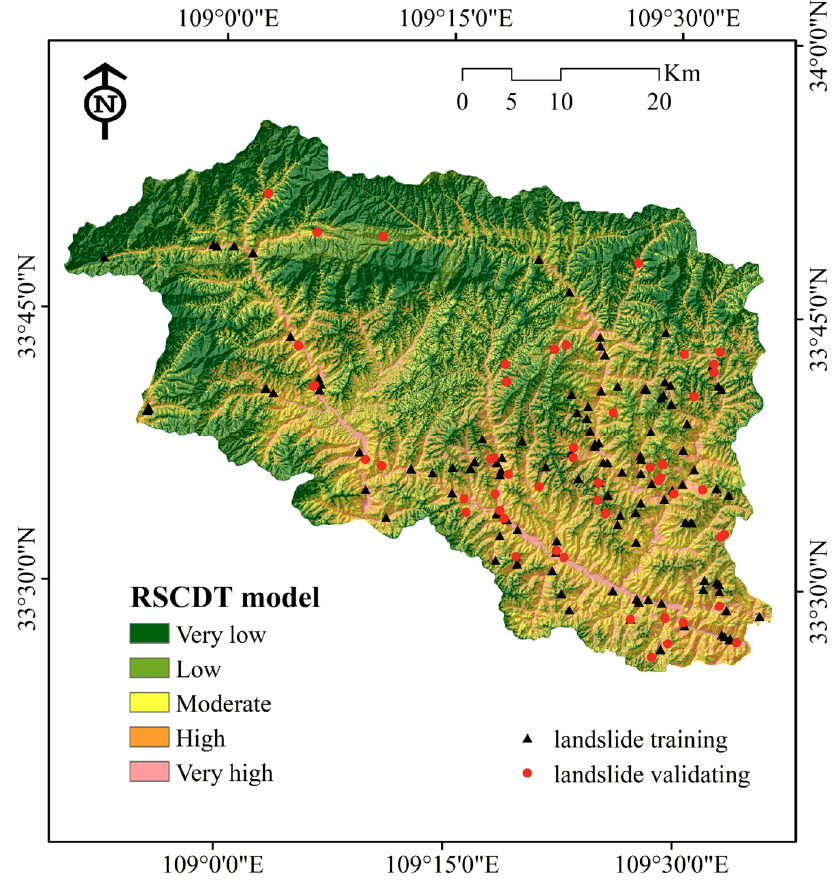
Figure 9. Landslide susceptibility map using the RSCDT model.